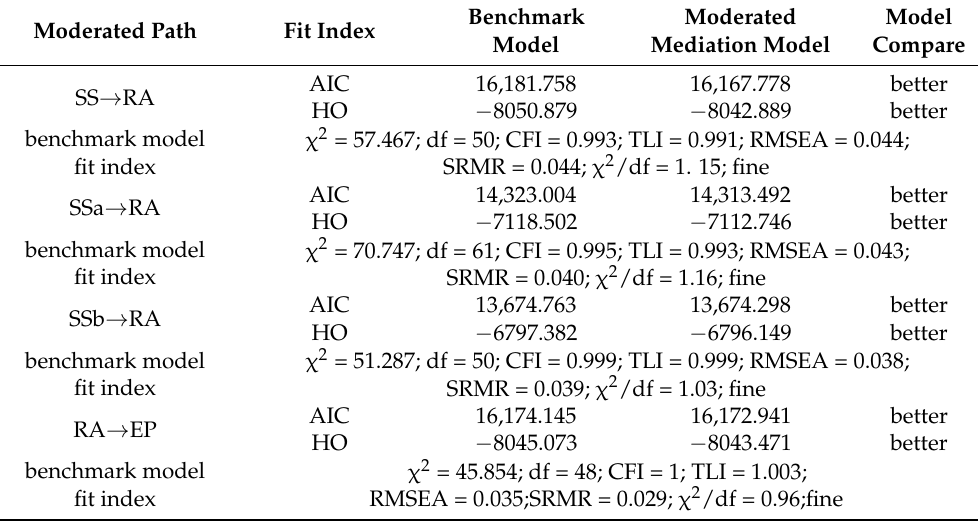
Table 7. Comparison between the benchmark model and moderated mediation model.